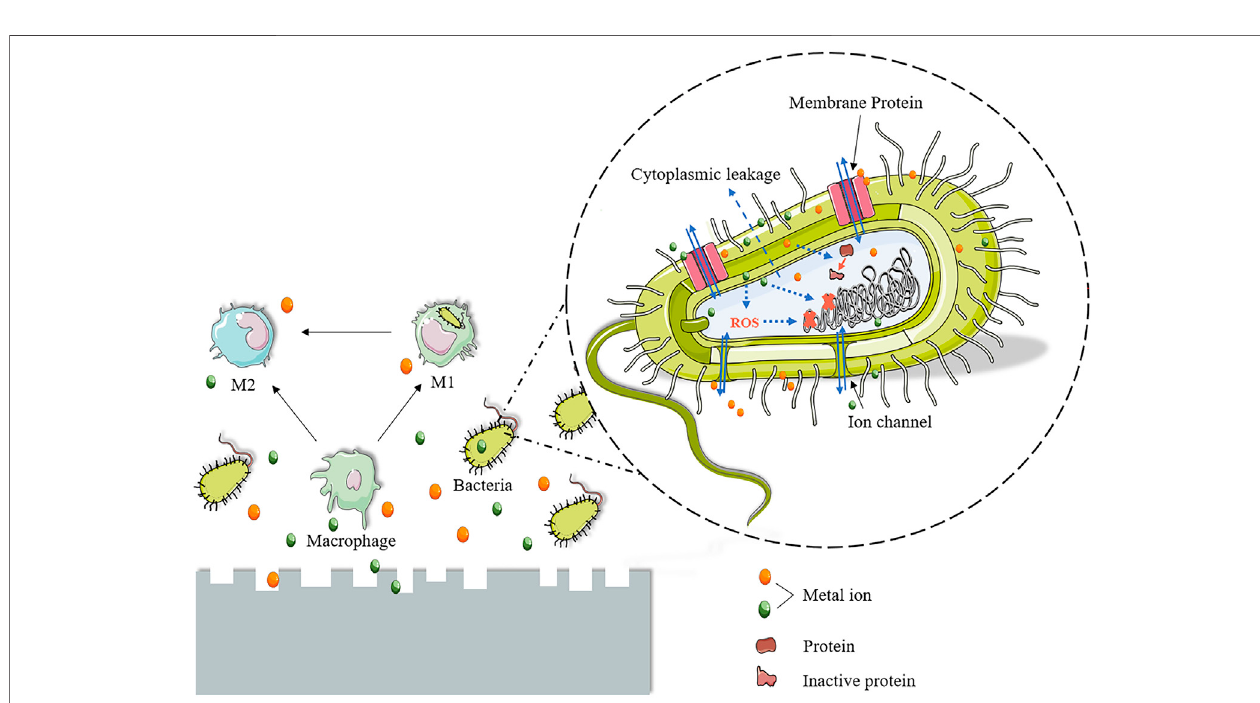
FIGURE2| Antibacterialmechanismofmetalions.Theeffectsofmetalionsreleasedbyalloysonbacteriaincludetwomajoraspects.Ontheonehand,thesemetal ionscanbindtobacterialmembranesandproteins,resultinginagreatlyincreasedcellmembranepermeability,whichmayleadtomassivecytoplasmicloss.Atthesame time, these metal ions enter the bacterial cytoplasm and interact with the sulfhydryl group of the protein, resulting in irreversible inactivation of the protein due to the cleavage of the ionic bond. Moreover, these metal ions also generate a large amount of reactive oxygen species (ROS). Ultimately, these events lead to the breakdown ofbacterial respiration and material transport and thedegradation of DNA. On the other hand, metal ions, Zn and Mg, have immunomodulatory antibacterial mechanisms. They can modulate the immune microenvironment by modulating the polarization of macrophages and ultimately play a role in bacterial clearance and killing and the control of in fl